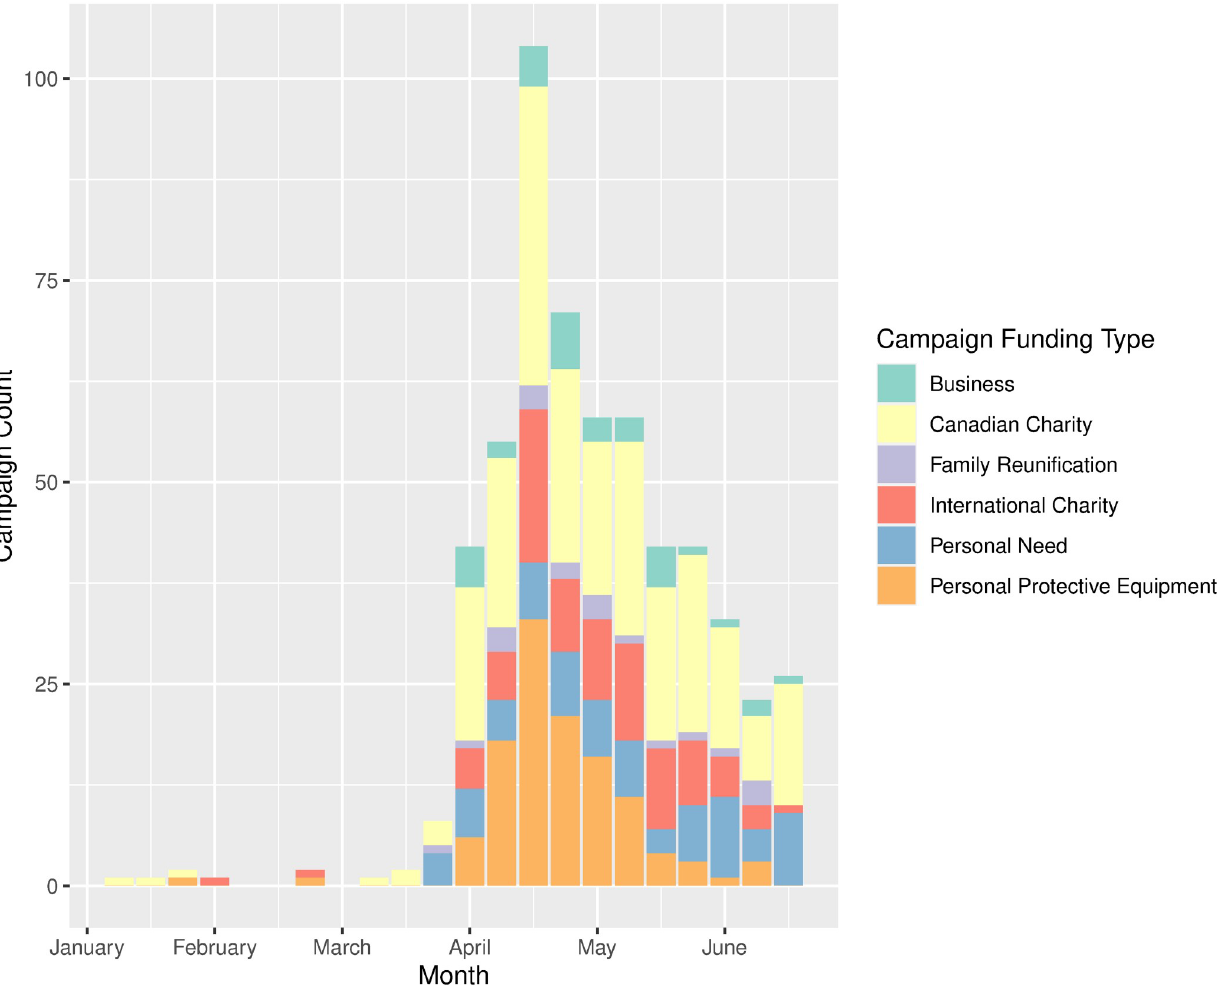
Fig 3. Campaign class type distribution per week of the study period from January to June 2020. Shows the trends in weekly campaign creation, stratified by campaign type, across the 22 week period within which all scraped campaigns were